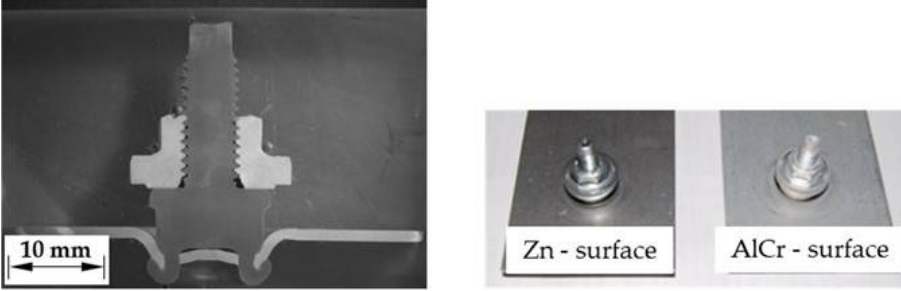
Figure 6. Performance factor k u of clinch joints depending on the time in accordance with [3].